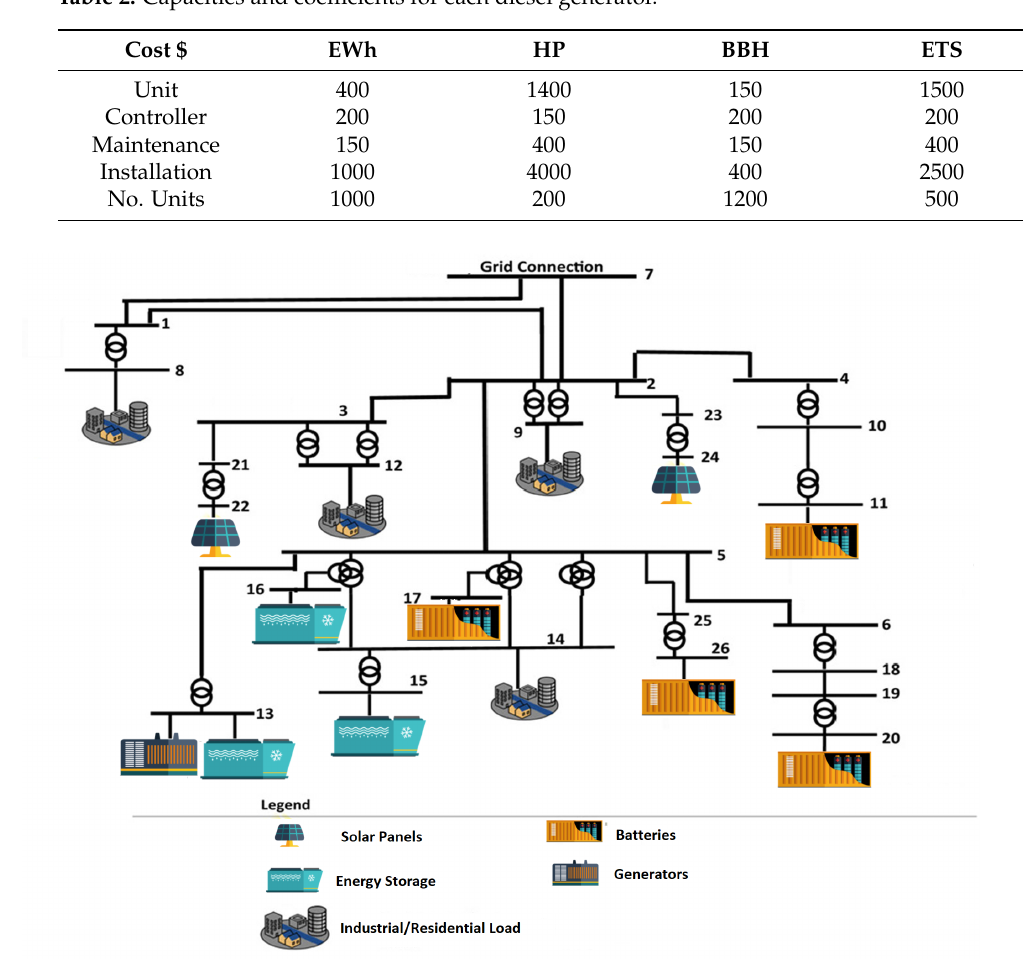
Figure 3. A real Australian power distribution